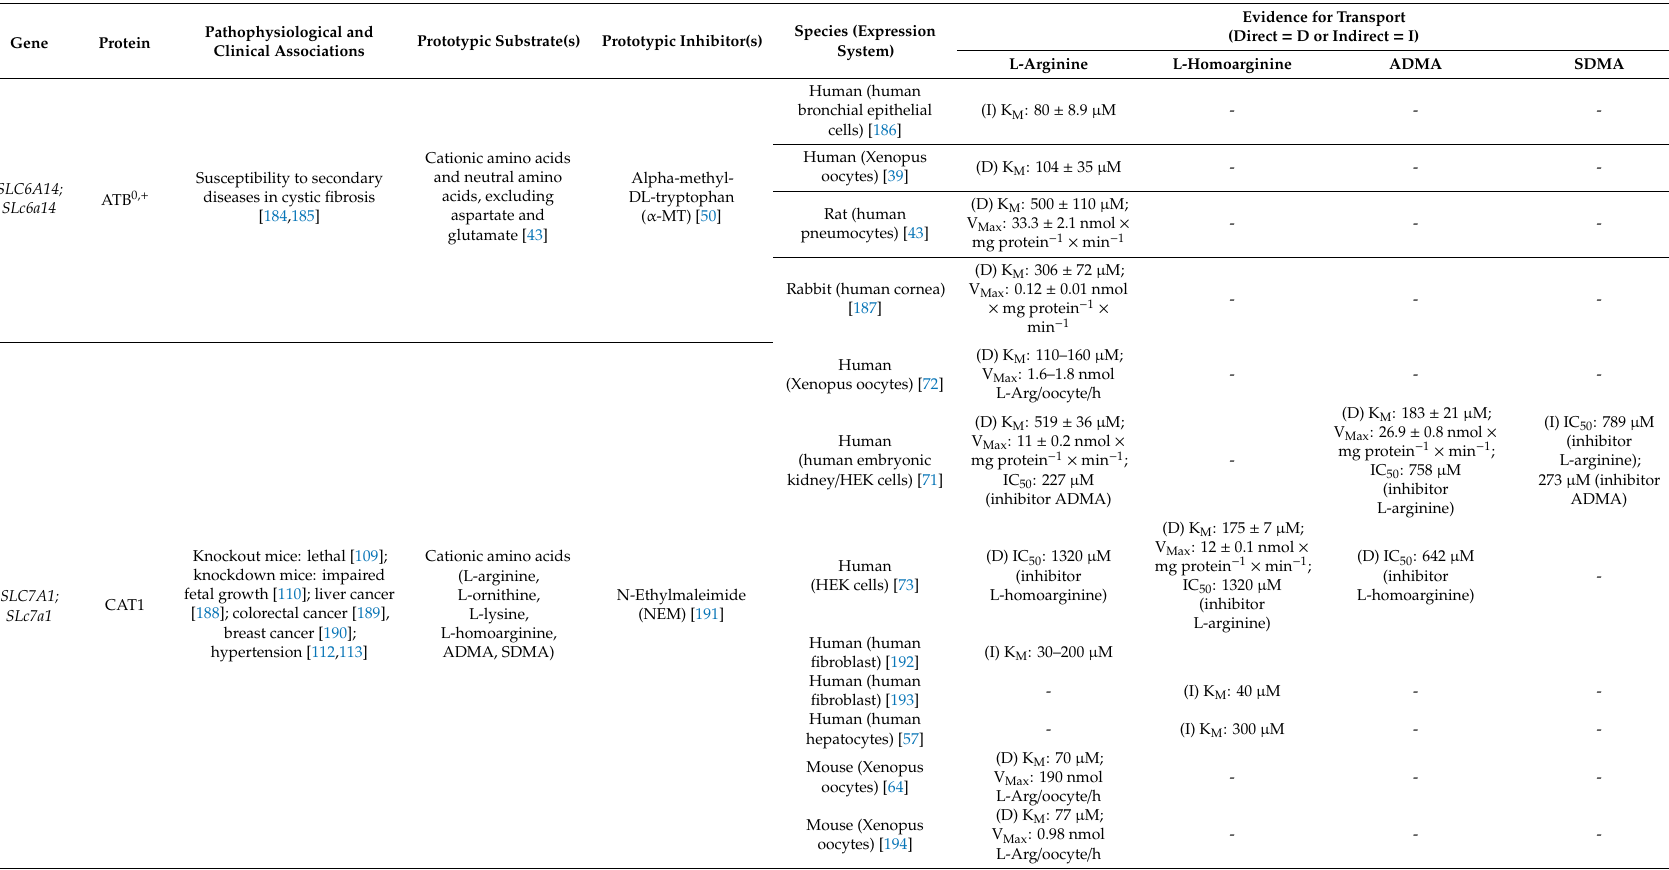
Table 5. Characteristics of plasma membrane transporters that accept L-arginine and its derivatives as